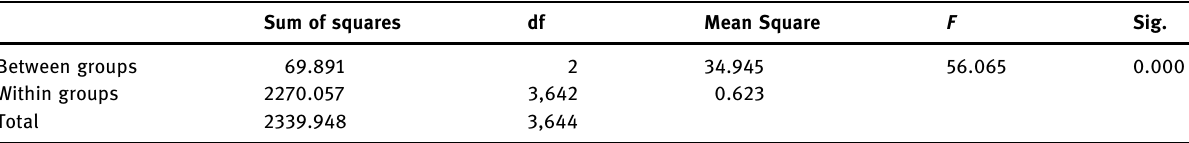
Table 24: Analysis of variance of awareness level by areas of expertise at VHS Sum of squares df Mean Square